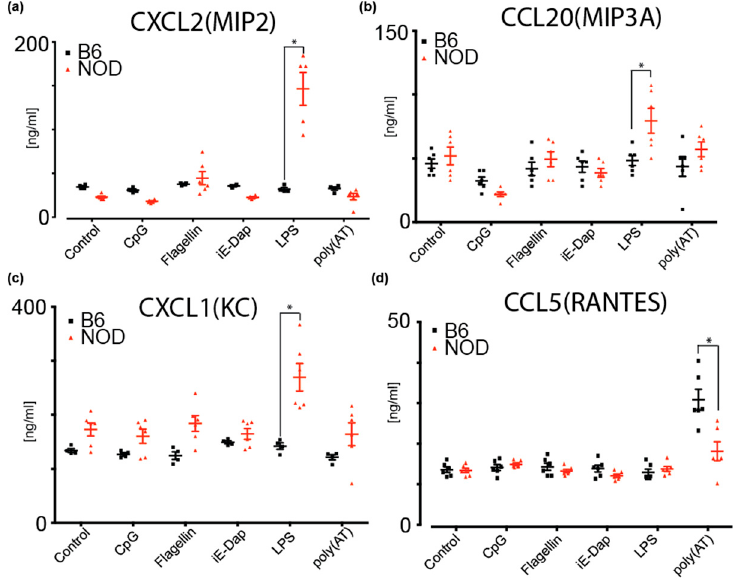
Figure 5. Multiplex ELISA measurements of cytokines and chemokines secreted by B6 or NOD ES cells upon stimulation by various triggers; ( a ) MIP2(CXCL2), ( b ) MIP3A(CCL20) and ( c ) KC(CXCL1) were shown to increase secretion from NOD ES cells upon LPS stimulation compared to B6 ES cells. ( d ) RANTES(CCL5) was shown to secrete more in B6 ES cells compared to NOD ES cells upon